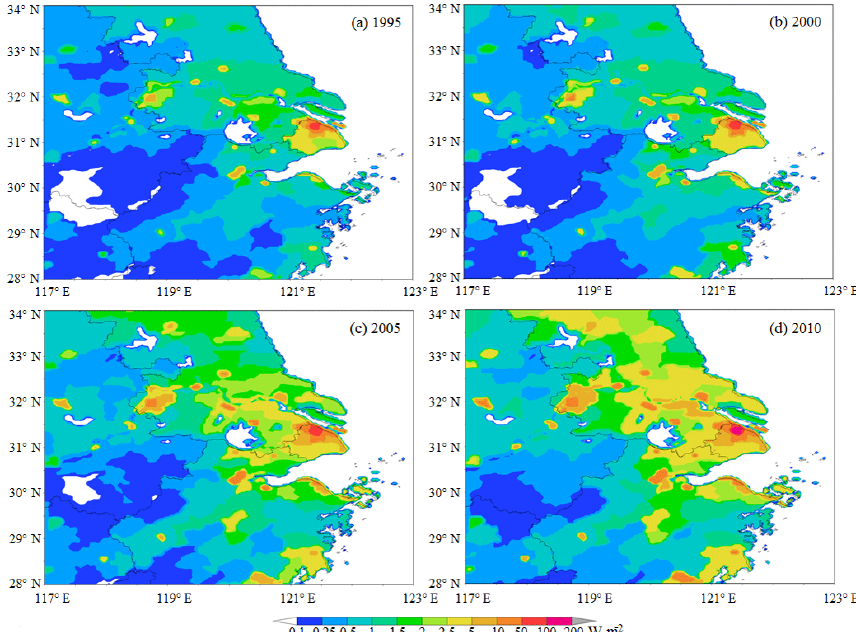
Figure 4. Estimates of annual-mean anthropogenic heat fluxes resulting from the consumption of non-renewable energy sources (coal, petroleum, natural gas, and electricity) and human metabolism between (117 ◦ E, 28 ◦ N) and (123 ◦ E, 34 ◦ N) with the resolution of 2.5arcmin for 1995 (a) , 2000 (b) , 2005 (c) and 2010 (d) , respectively. Table 2. The statistics of annual average anthropogenic heat flux in different administrative districts over the YRD region (Wm − 2 ). Province or municipality This study Previous results